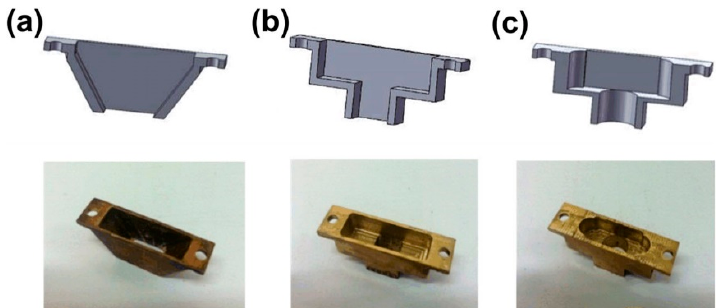
Figure 9. Cross section of the three proposed designs of shielding gas nozzles for LAHW: ( a ) trapezoidal nozzle, ( b ) square nozzle with square section and ( c ) square nozzle with circular section. (Reproduced from [75] with permission, Springer London, 2017).